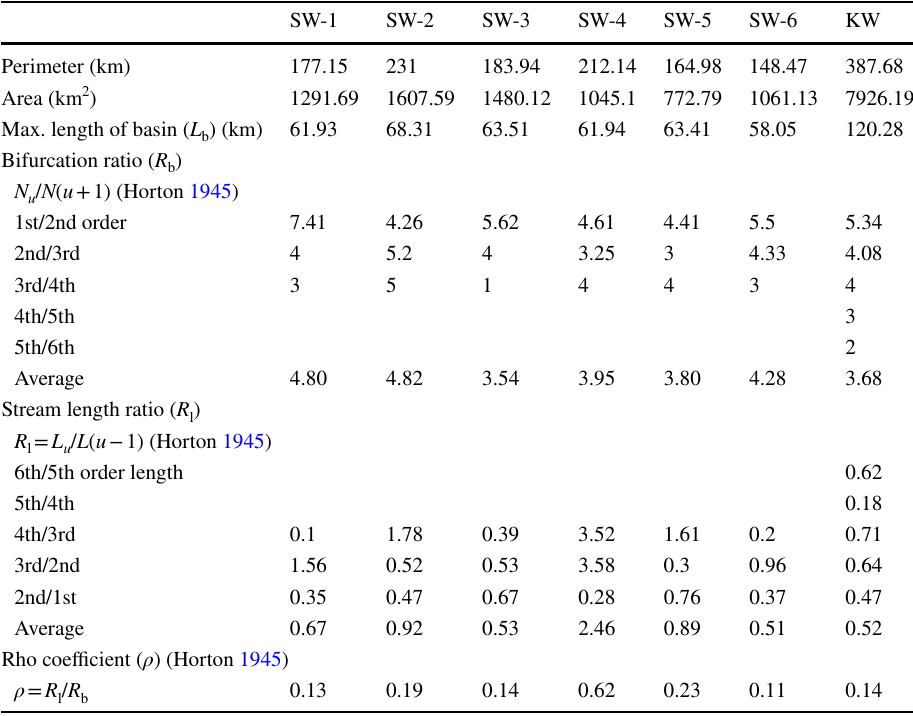
Table 1 Mathematical formulae and their observed values of linear